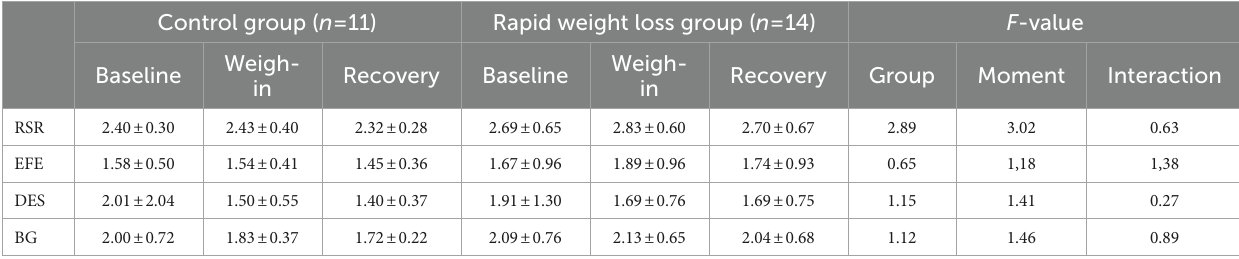
TABLE 3 Values of burnout components of combat sports athletes submitted or not to weight loss to